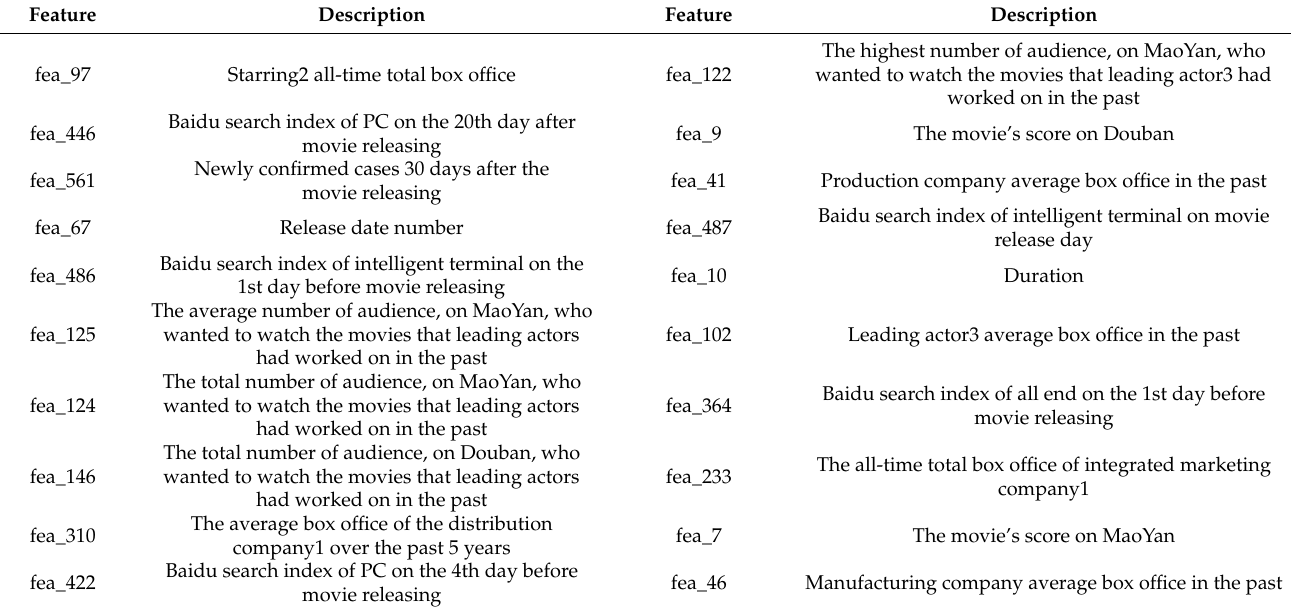
Table 8. Important features of LightGBM and features’